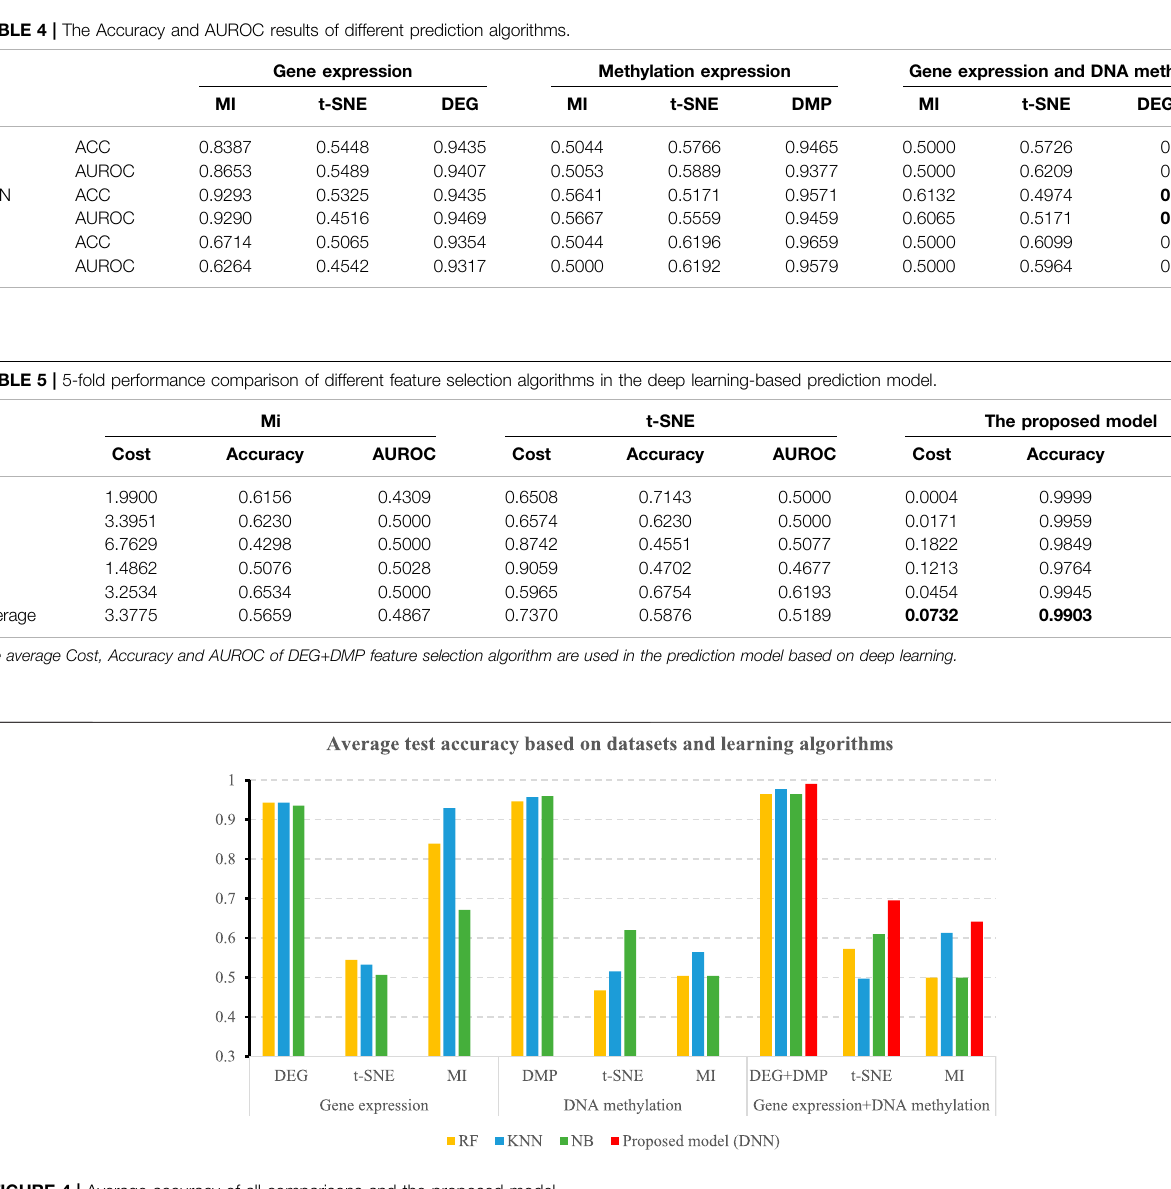
FIGURE 4 | Average accuracy of all comparisons and the proposed